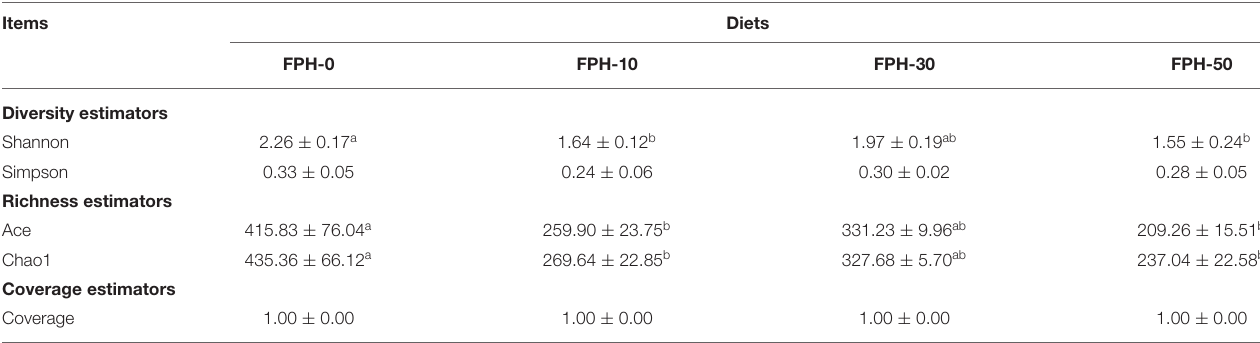
TABLE 8 | Alpha diversity analysis of the intestinal microflora of largemouth bass ( Micropterus salmoide s) fed the diets containing different supplementation levels of fish protein hydrolysate (FPH)*. Items